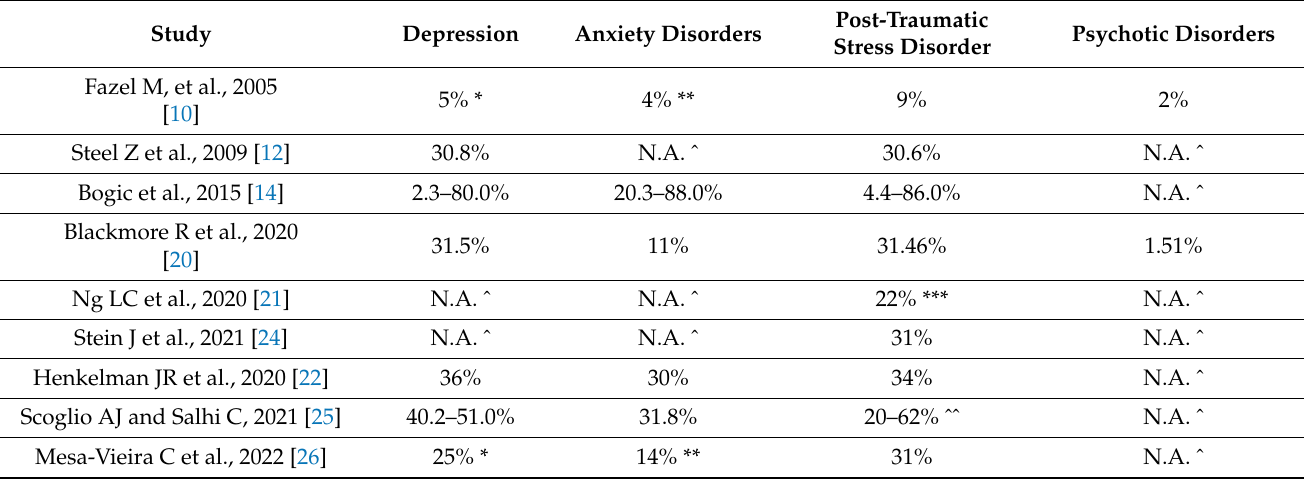
Table 2. Prevalence rates of mental disorders in systematic reviews/meta-analyses conducted on samples of adult refugees/asylum seekers.